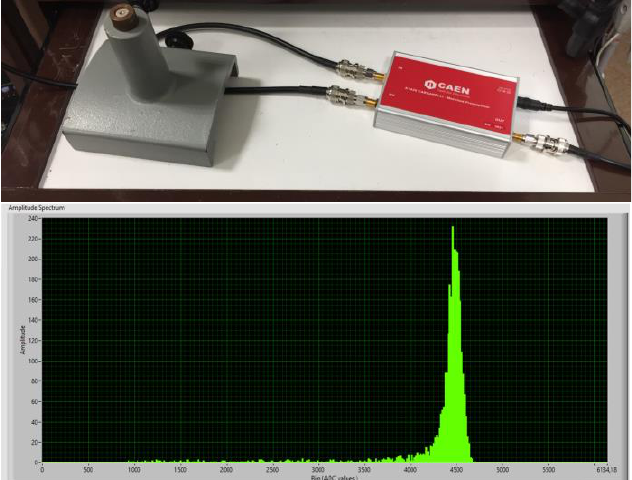
Fig. 10. The measurement setup and the amplitude spectrum from a calibrated americium-241 α-particle source. The relative amplitude measurement error, calculated in this experiment, was 4%, but figures for the noise to signal ratio in the channel are yet to be acquired.